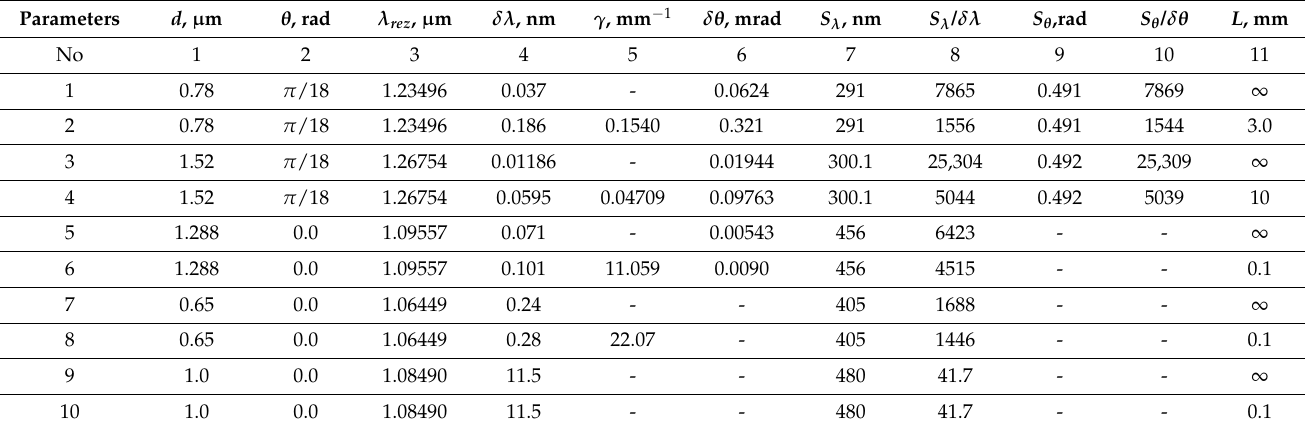
Table 1. Parameters of the grating (columns 1,2) and beam (column 11), as well as the results of numerical analysis (columns 3–10).